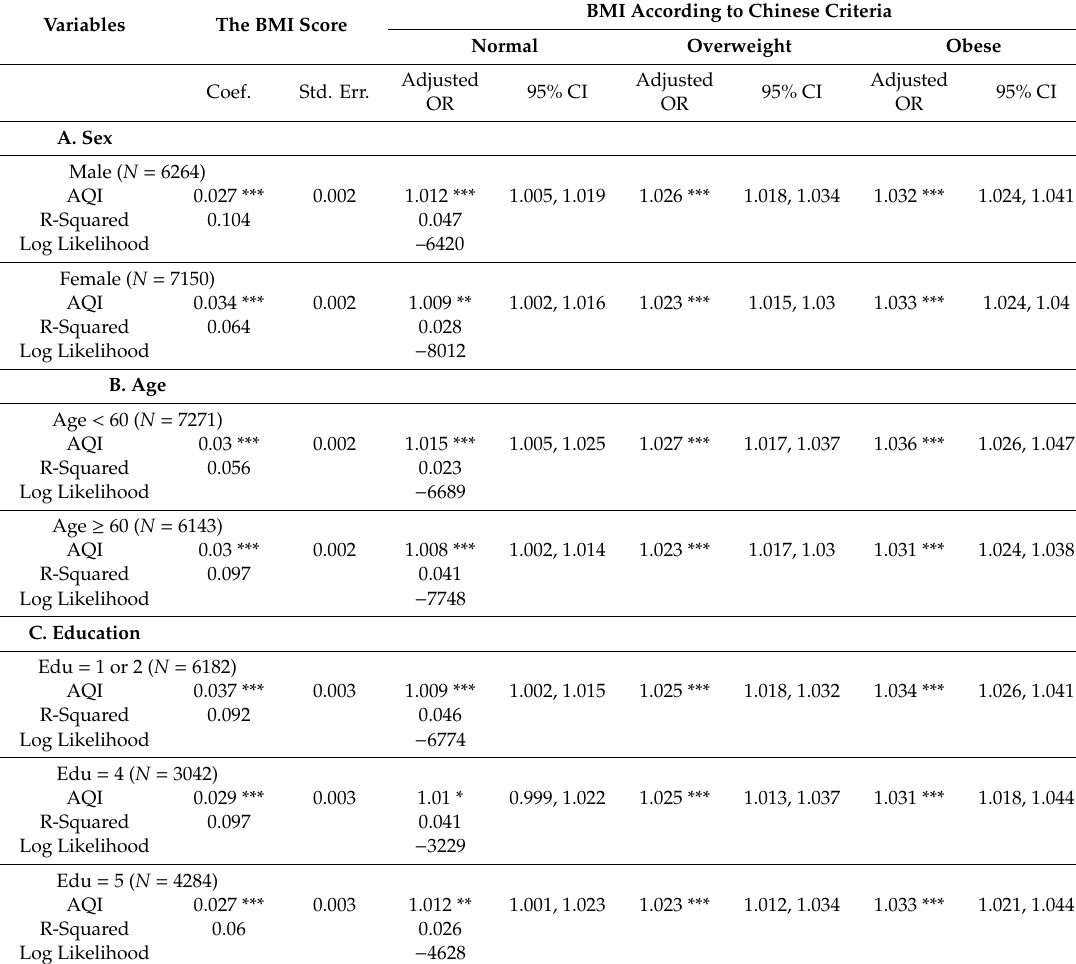
Table 9. E ff ect of Air Quality Index (AQI) on Body Mass Index (BMI): by sex, age, and